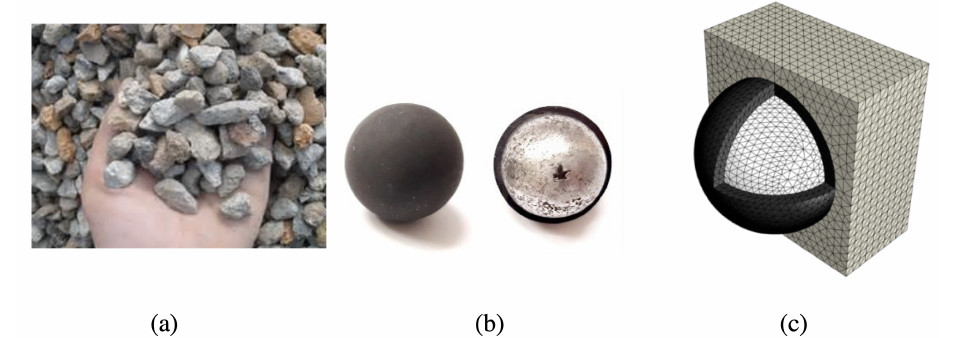
Figure 1. Traditional (a) and engineered inclusions (b); a finite element model of a single metaconcrete resonant unit (c) is used to study metaconcrete microscale dynamic